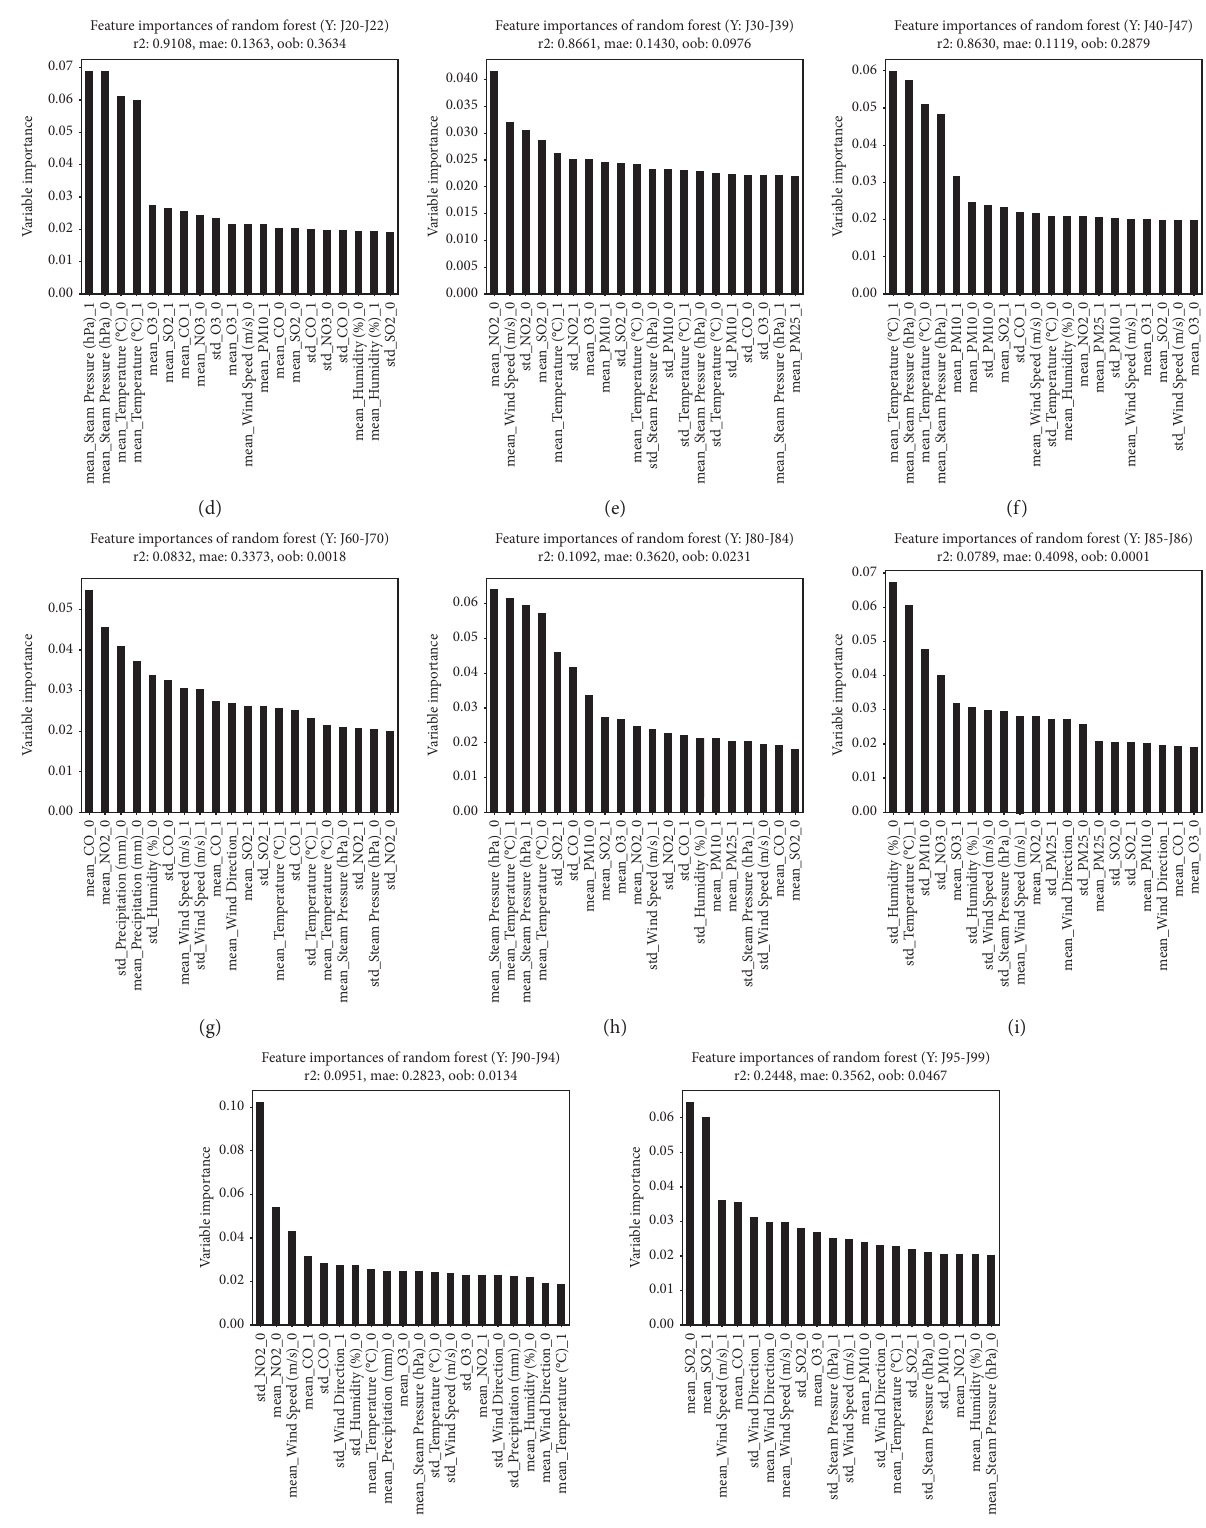
Figure 3: Analysis of the correlation between respiratory disease patients’ visit to the ED and air pollution and weather variables (day 0–1). (a) [J00-J06] Acute upper respiratory infections. (b) [J09-J11] Influenza. (c) [J12-J18] Pneumonia. (d) [J20-J22] Other acute lower re- spiratory infections. (e) [J30-J39] Other diseases of upper respiratory tract. (f) [J40-J47] Chronic lower respiratory diseases. (g) [J60-J70] Lung diseases due to external agents. (h) [J80-J84] Other respiratory diseases principally affecting the interstitium. (i) [J85-J86] Suppurative and necrotic conditions of lower respiratory tract. (j) [J90-J94] Other diseases of pleura. (k) [J95-J99] Other diseases of the respiratory